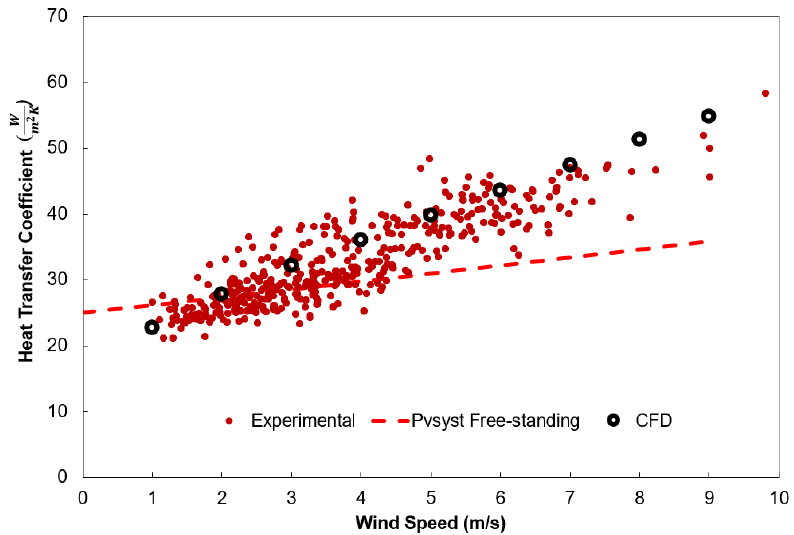
Figure 12. Thermal loss factor from experimental and CFD simulations with varying wind speeds and solar irradiance. Table 5. Reported values for U c and U v considering no wind dependency (NWD) and wind dependent (WD). Free-Standing